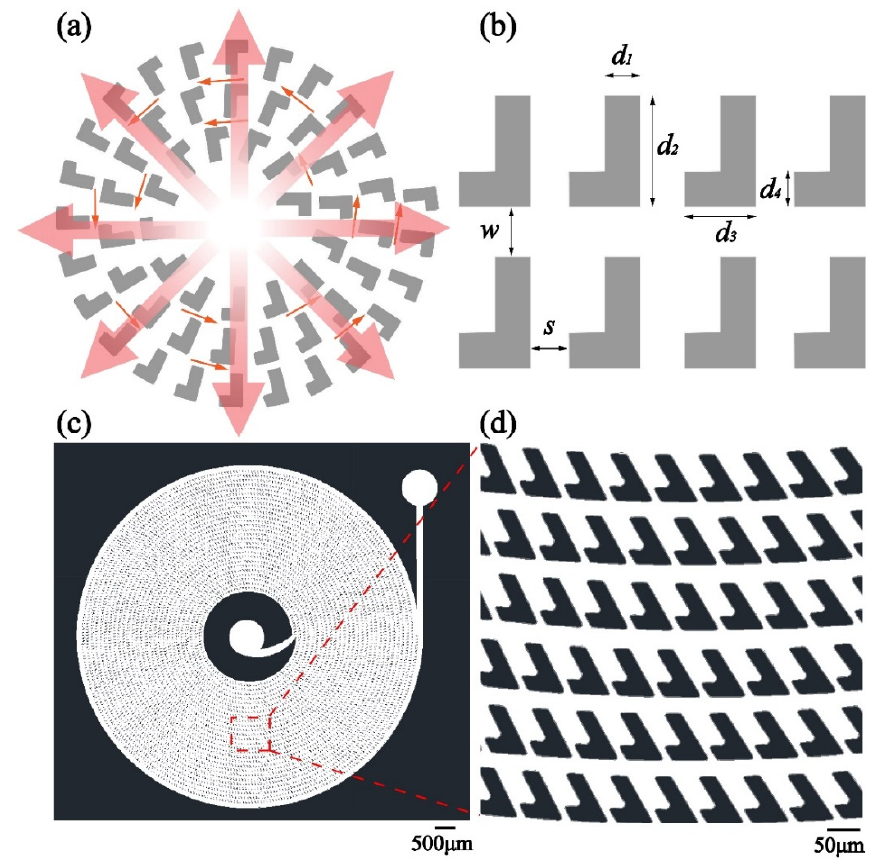
Figure 1. ( a ) Schematic diagram of the dentate spiral microfluidic channel. ( b ) The structure of the “L”-shaped dentate blocks. ( c ) Design of the microfluidic pattern. ( d ) The structure of a group of the dentate blocks, forming the traps.